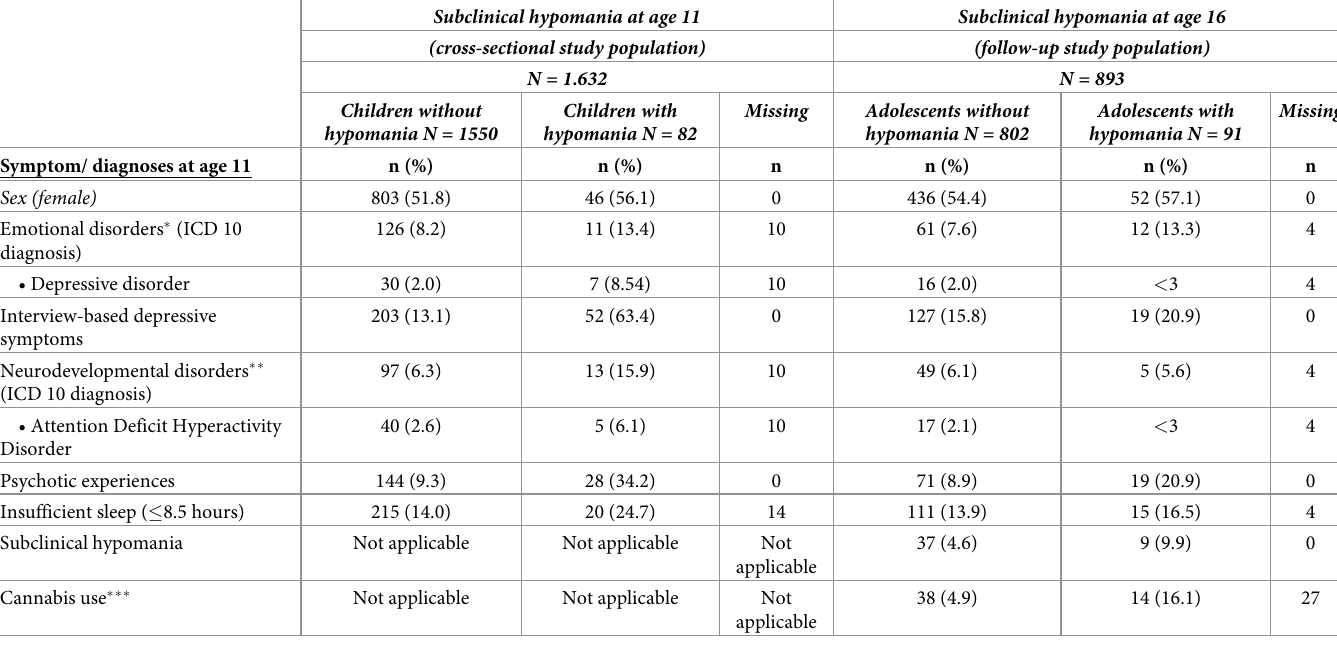
Table 2. Distribution of youth sex, mental health symptoms and diagnoses at age 11 by lifetime presence of subclinical hypomania (SHM) at age 11 and 16 years.